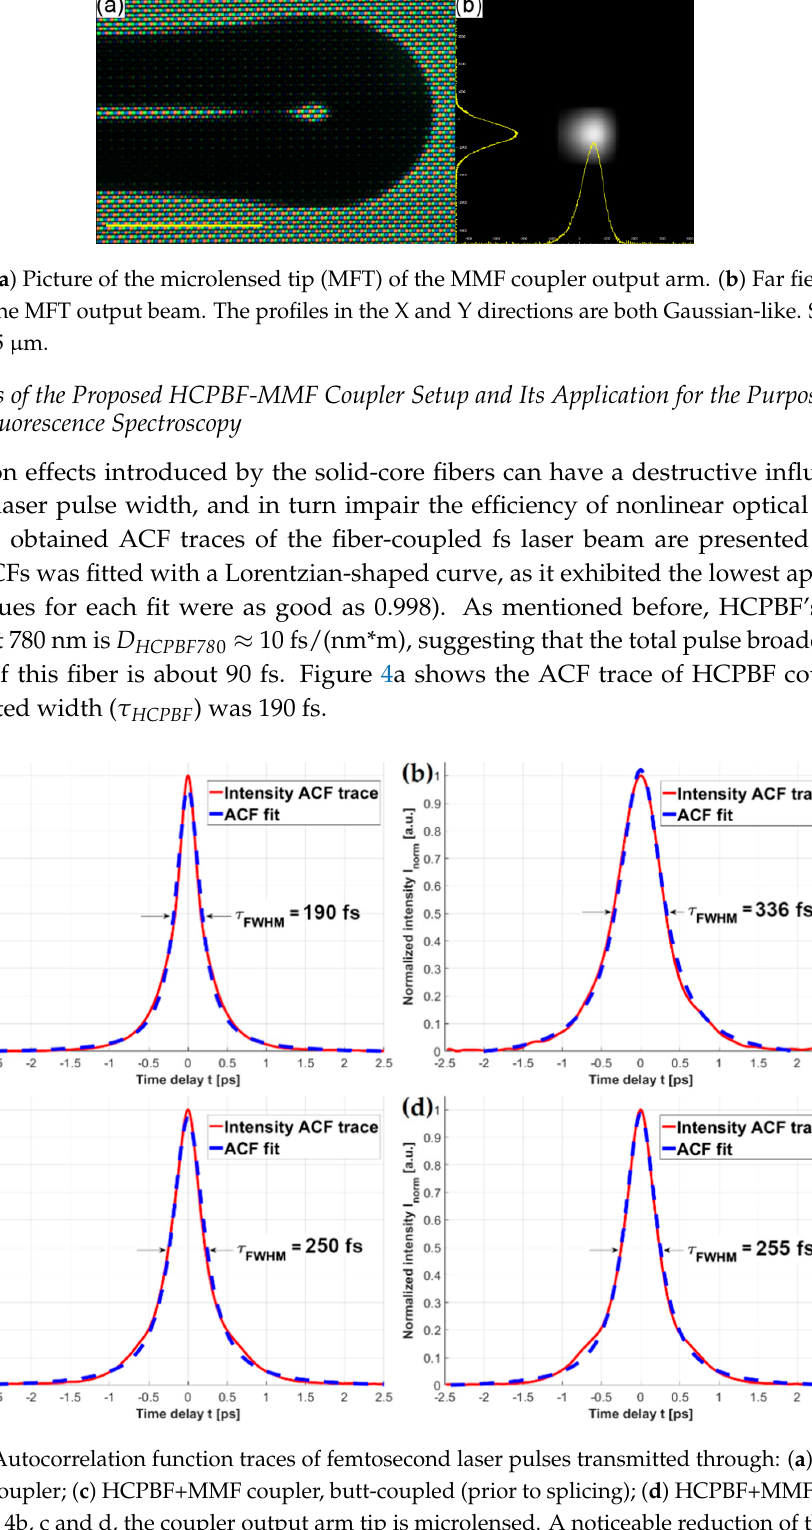
Figure 4. Autocorrelation function traces of femtosecond laser pulses transmitted through: ( a ) HCPBF; ( b ) MMF coupler; ( c ) HCPBF+MMF coupler, butt-coupled (prior to splicing); ( d ) HCPBF+MMF coupler, spliced. In 4b, c and d, the coupler output arm tip is microlensed. A noticeable reduction of the pulse width ( τ FWHM ) can be observed in the case of the combined HCPBF and MMF coupler, showing the feasibility of compensating dispersion effects, introduced by the solid-core fiber elements, with HCPBF.